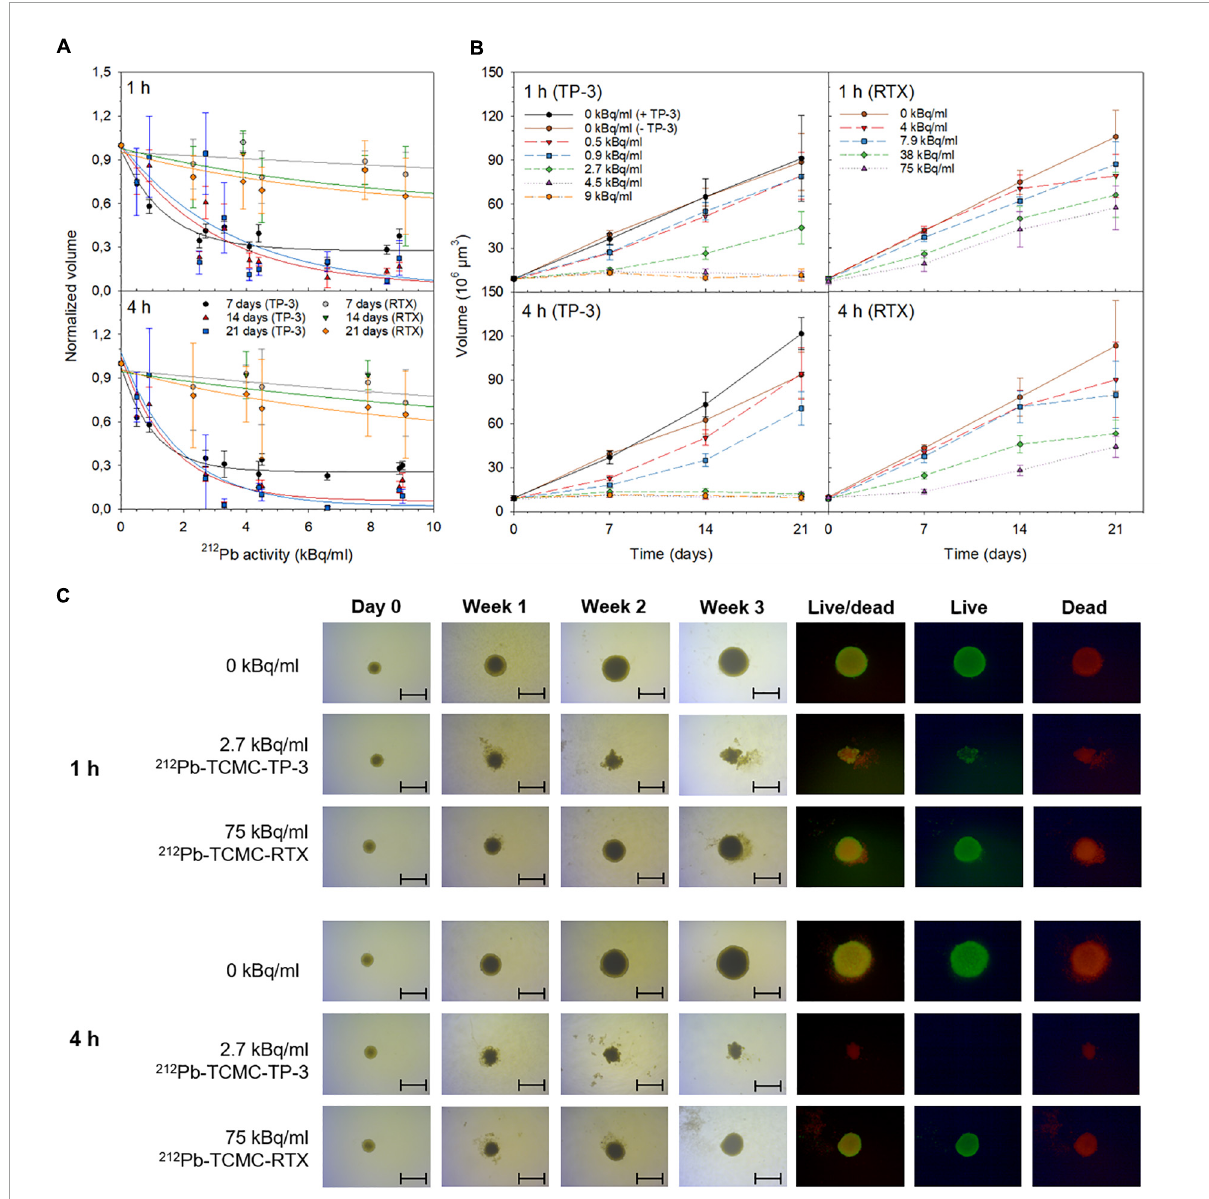
FIGURE2 Cytotoxicity of single alpha solutions. The influence of 212 Pb-TCMC-TP-3 or 212 Pb-TCMC-rituximab (RTX) on OHS spheroid growth after 1 or 4 h treatment at (A) increasing 212 Pb-activities and (B,C) over time. The normalized volume was calculated by dividing the volume of the treated spheroid by the volume of untreated spheroids (0 kBq/ml) at each time point. (C) Microscope images (4 × magnification, scale bar = 500 µ m) were taken from the day of treatment (day 0, 8.5 ± 0.5 × 10 6 µ m 3 ) to week 3. At the experimental end point (week 3), spheroids were stained with fluorescein diacetate and propidium iodide to observe live and dead cells, respectively. All spheroid images were taken by an inverted Axiovert 200M microscope (Carl Zeiss AG) and analyzed with the AxioVision Rel. 4.8 software (Carl Zeiss AG). Specific activities were 7.3–15.4